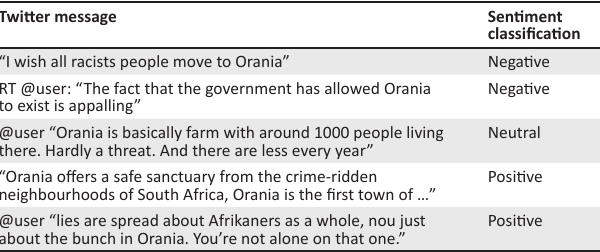
TABLE 7: Examples of sentiment